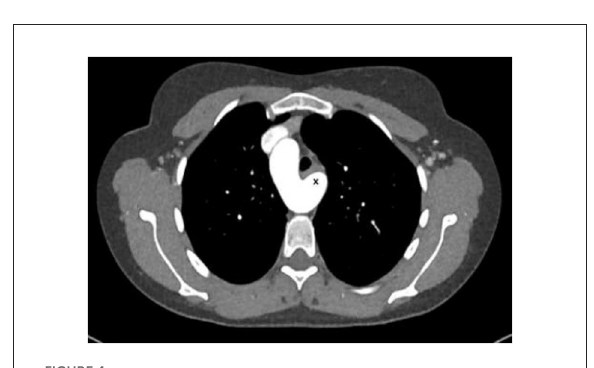
FIGURE4 Right descending aortic arch with left arteria lusoria originating from a Kommerell diverticulum (*) with compression of the trachea. Reproduced with permission from Cardiovasc Med: w10132: doi